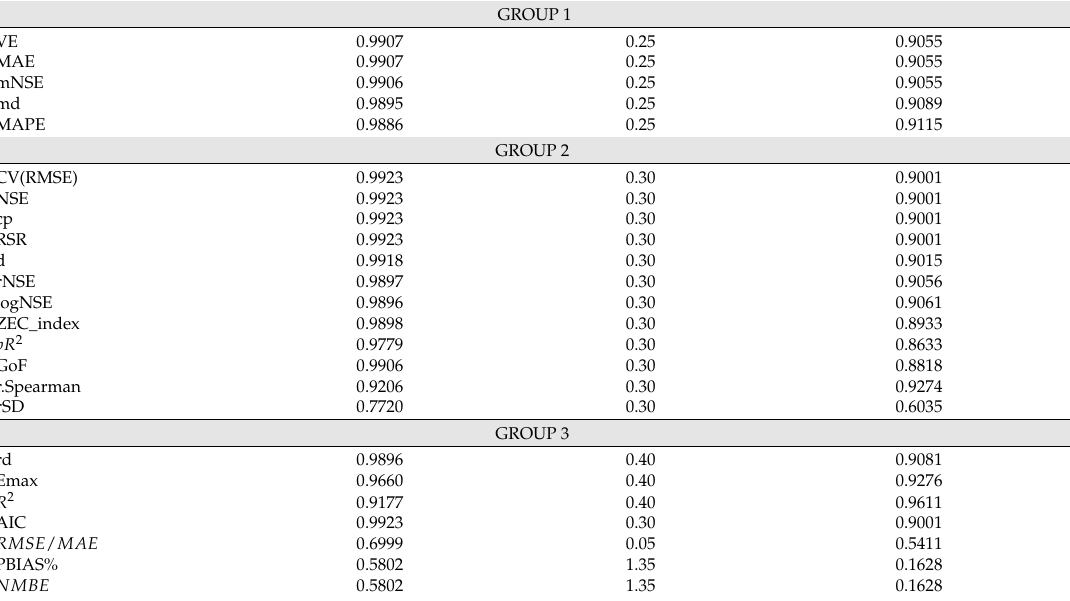
Table 7. (Synthetic case) Group index segmentation by the λ value where the uncertainty indices calculated on weighted mean temperatures and p − f actor ( λ ) reach the maximum correlation, in absolute value. The calculated p -values for these correlations are above 0.97 in most cases. The considered λ values are taken within the interval [0.05,